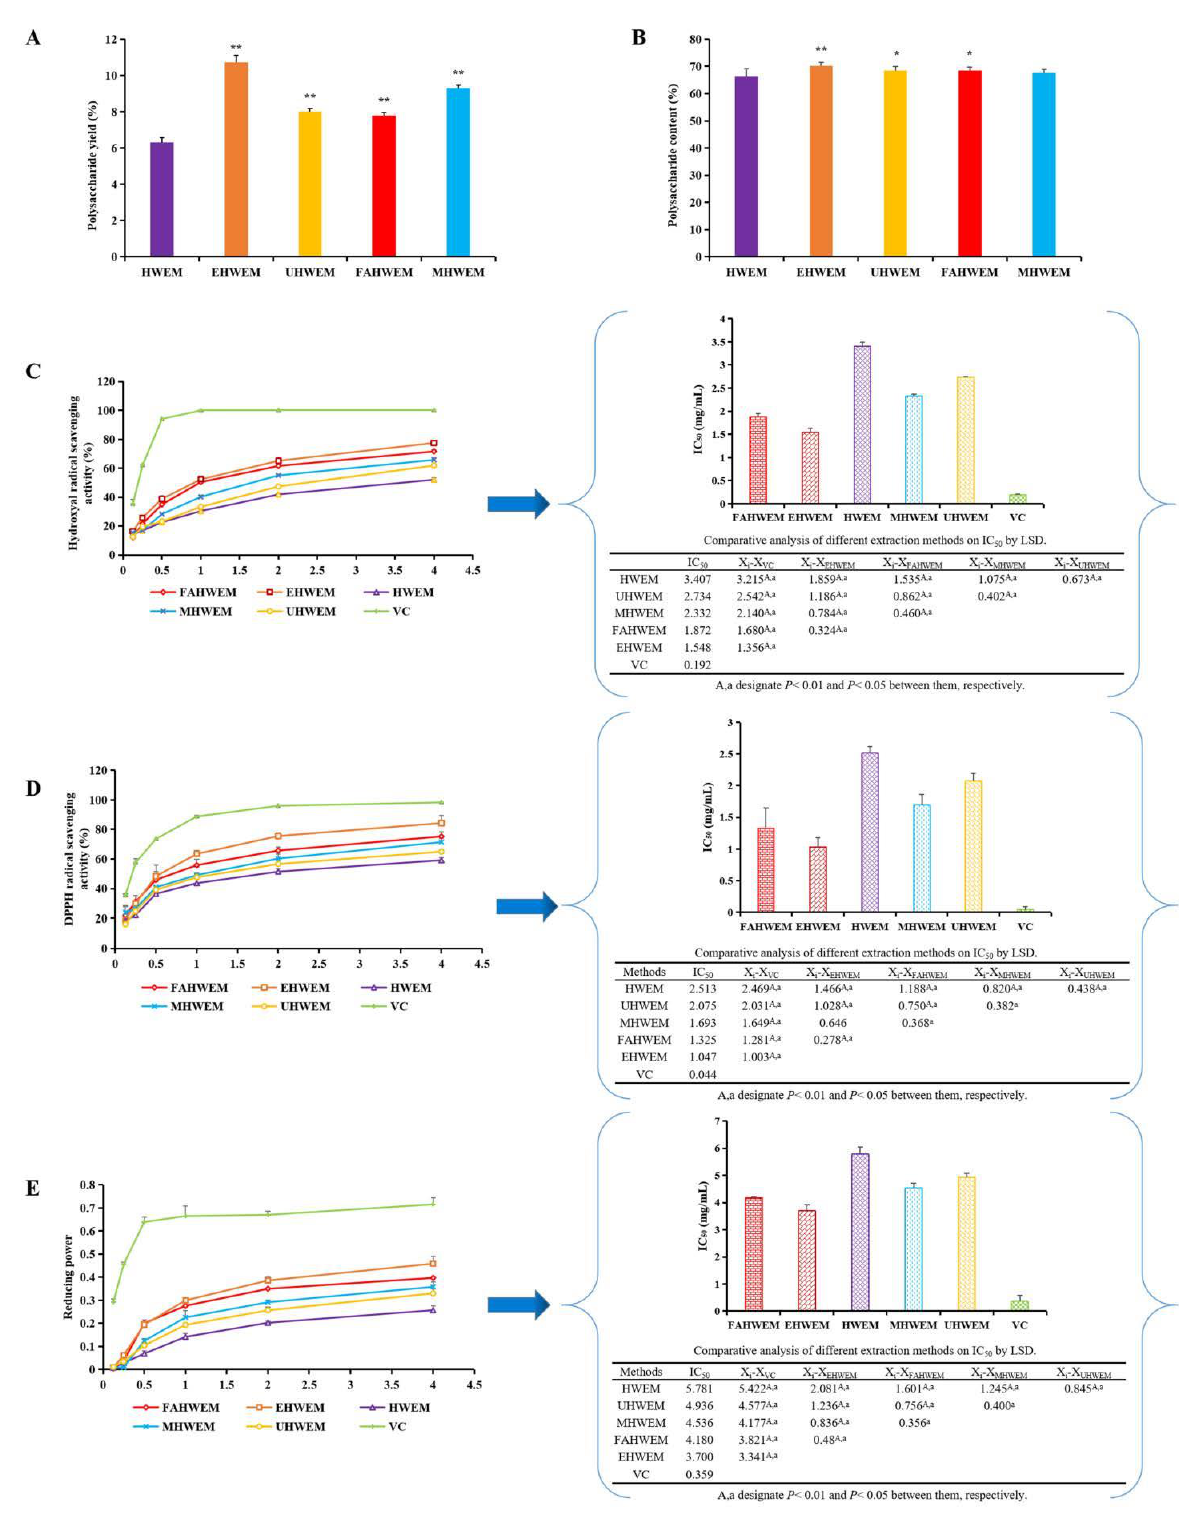
Figure 1. Comparison of polysaccharide yield ( A ) (means ± SD, n = 9), polysaccharide content ( B ) (means ± SD, n = 9), and antioxidant activity ( C – E ) (means ± SD, n = 3) of PAP were obtained by different extraction methods. HWEM, hot water extraction method; EHWEM, enzyme-assisted hot water extraction method; UHWEM, ultrasonic-assisted hot water extraction; MHWEM, microwave-assisted hot water extraction; FAHWEM, freeze-thaw assisted hot water extraction. Bars with * and ** indicate significant difference or most significant difference with the HWEM group, respectively ( p < 0.05 or p < 0.01). “A, a” designate p < 0.05 or p < 0.01 between